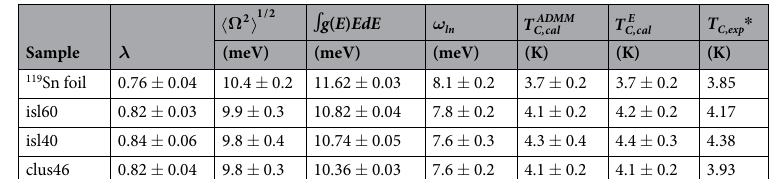
1/2 calADMM Table 3. λ , Ω 2 , ∫ g ( E ) EdE , ω ln , T calculated for all samples, using μ * = 0.117 and T C , all samples, using μ * = 0.119. The last column shows the experimentally obtained critical temperature, T C , exp * (the error on T C , exp is 0.05 K for all samples and is determined by the temperature stability of the SQUID magnetometer, the errors indicated for the other quantities are based on the statistical error of the PDOS).